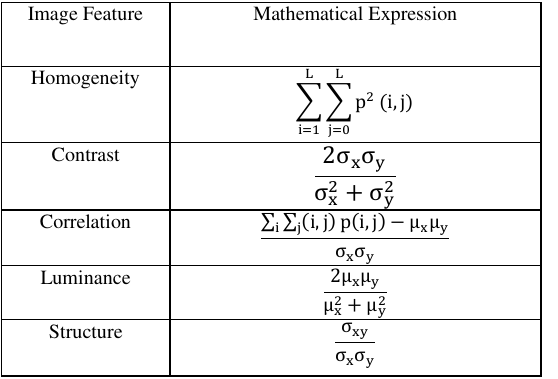
Table 1: Mathematical expression for the image features extracted for GlCM and SSIM manipulation Image Feature